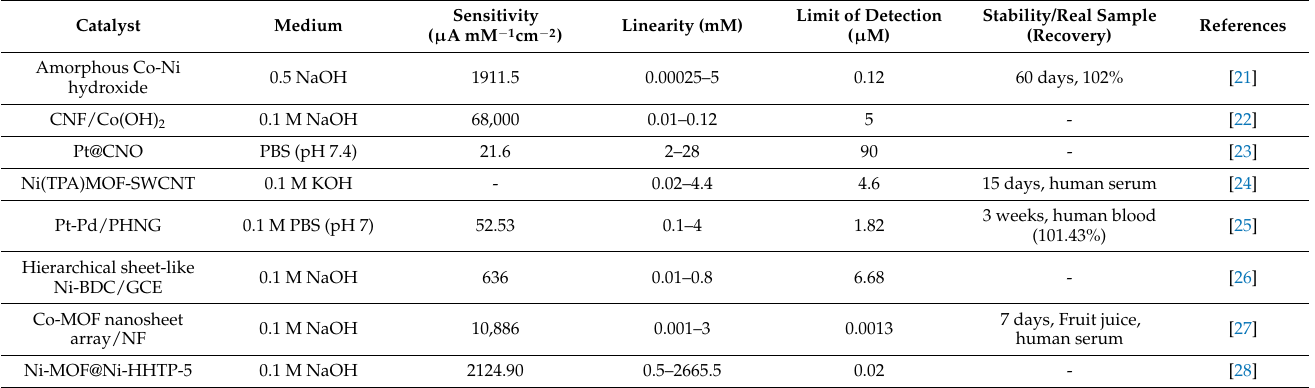
Table 2. Comparison of the nonenzymatic glucose sensing properties of 2D MOFs with other